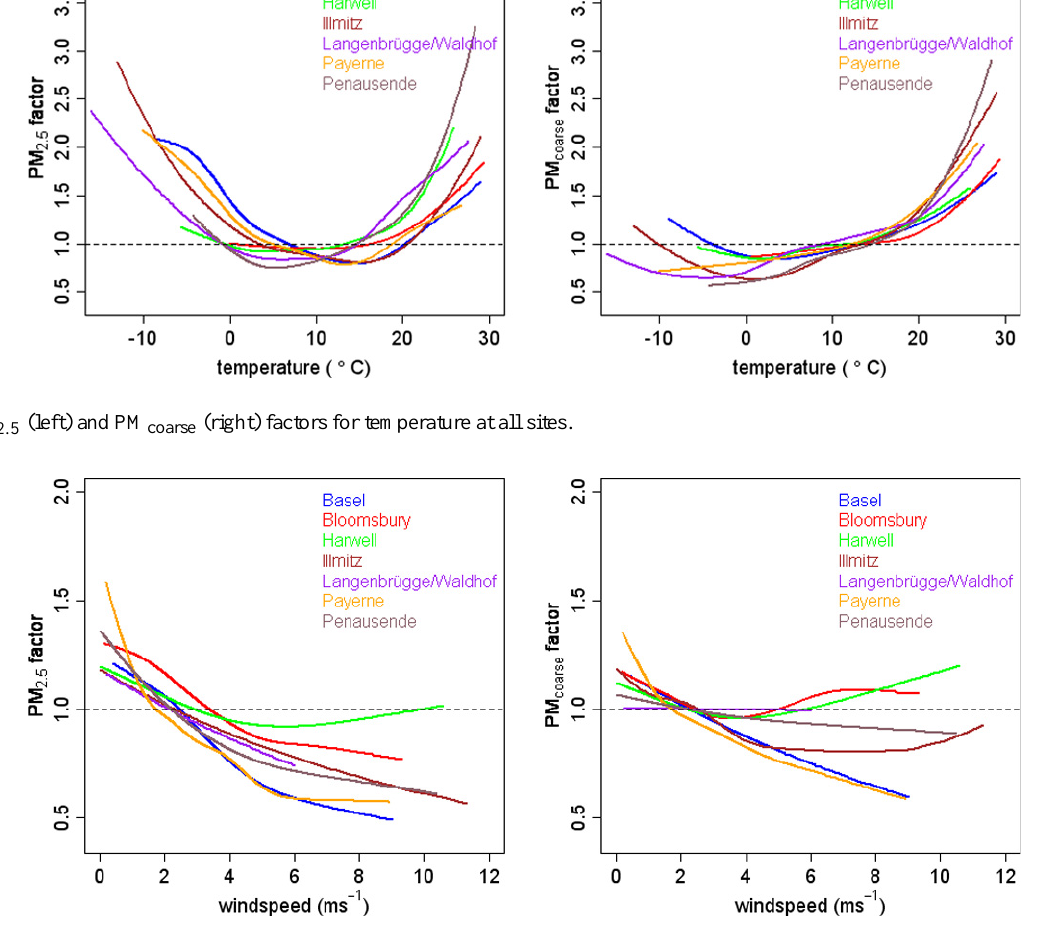
Fig. 3. PM 2 . 5 (left) and PM coarse (right) factors for wind speed at all